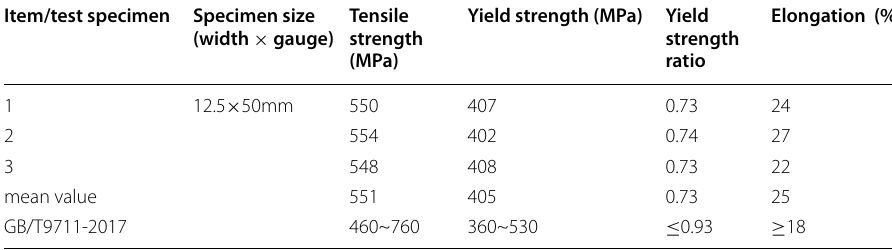
Table 6 Results of tensile test